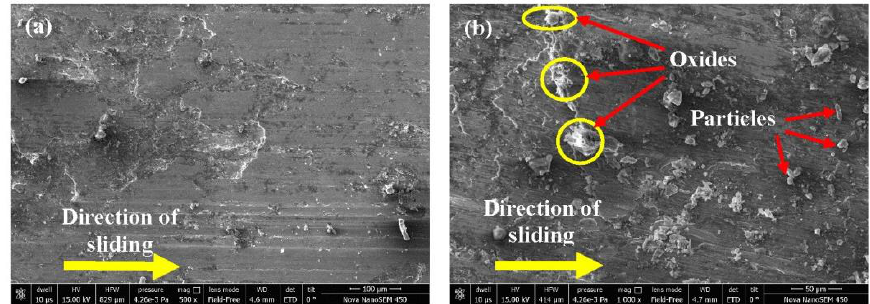
Fig. 10. FESEM images of worn surfaces of the base alloy at 3 h aging time, 2.5 m/s sliding speed and 24.52 N applied load. (a) at lower magnification (b) at higher